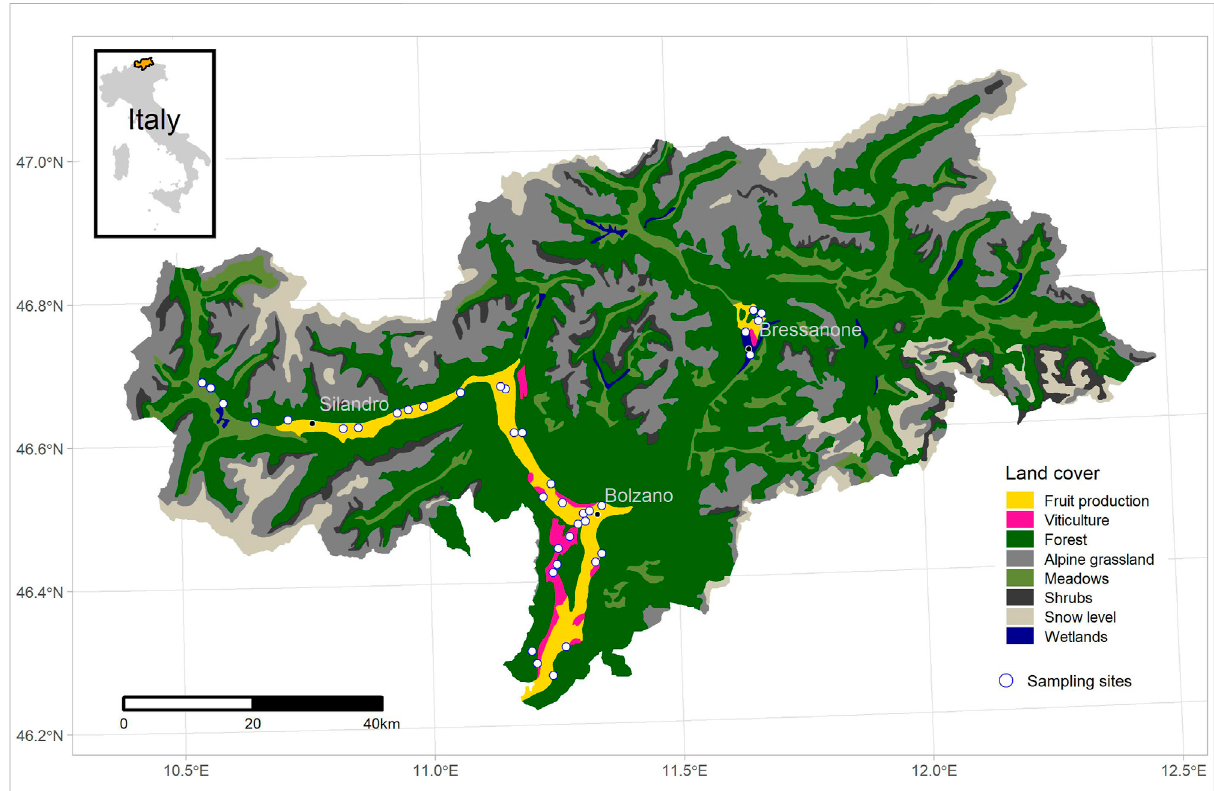
FIGURE 1 Situation of our sampling sites (white dots, n = 39, 2018 – 2021, see also Supplementary Table S1) within main valleys of South Tyrol (Bolzano province, Trentino-Alto Adige, Italy). Area of intensive fruit production is given in yellow (21 552 ha, year